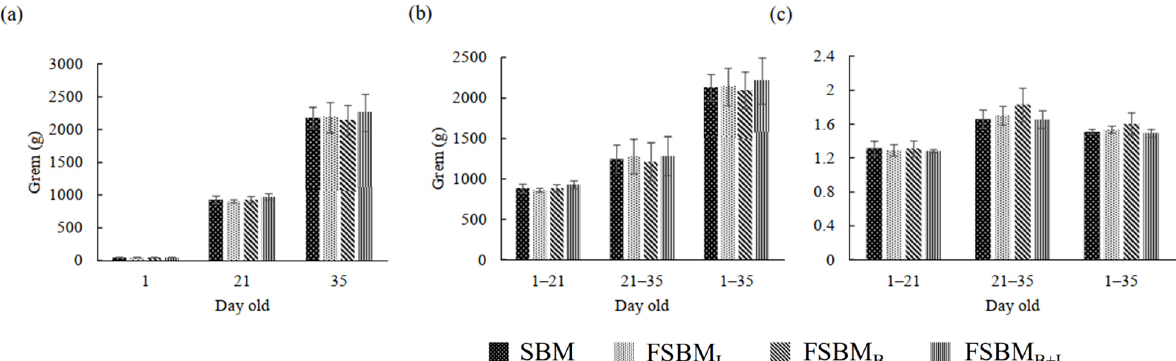
Figure 2. Effect of two-stage FSBM on Body weight ( a ), body weight gain ( b ), and feed conversion ratio ( c ) of broilers. Each value represents the mean ± standard deviation (n = 4). SBM: Soybean meal; FSBM L : commercial control; FSBM B : SBM one-stage fermented by Bv; FSBM B+L : SBM two-stage fermented by Bv and Lb.